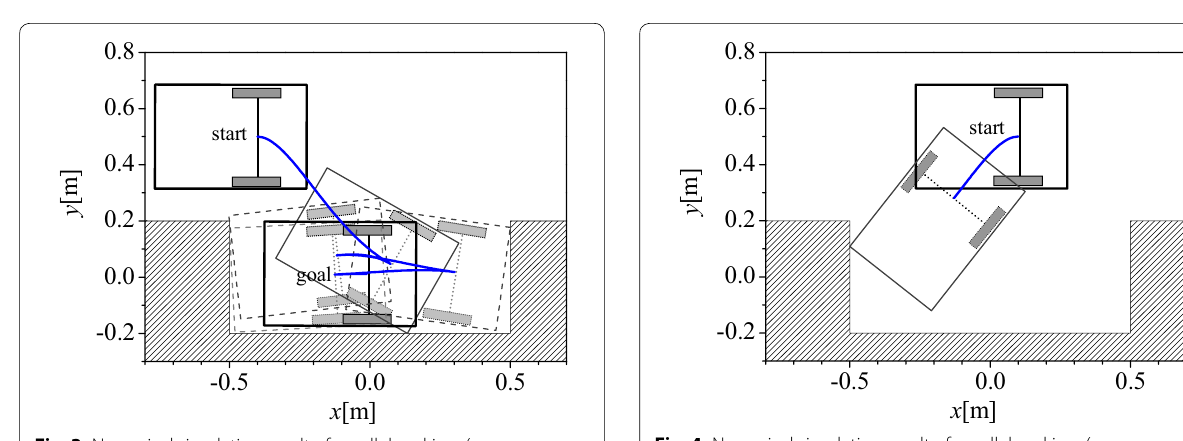
Fig. 3 Numerical simulation result of parallel parking, ( x 0 , y 0 , θ 0 ) ( 0.4, 0.5 m, 0°) = −